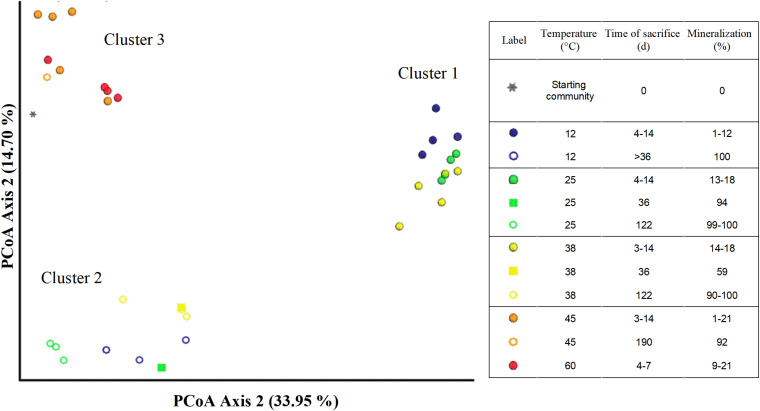
Principal coordinate plots (Bray–Curtis) of microbial communities in microcosms from different treatments and time points of sacrifice.